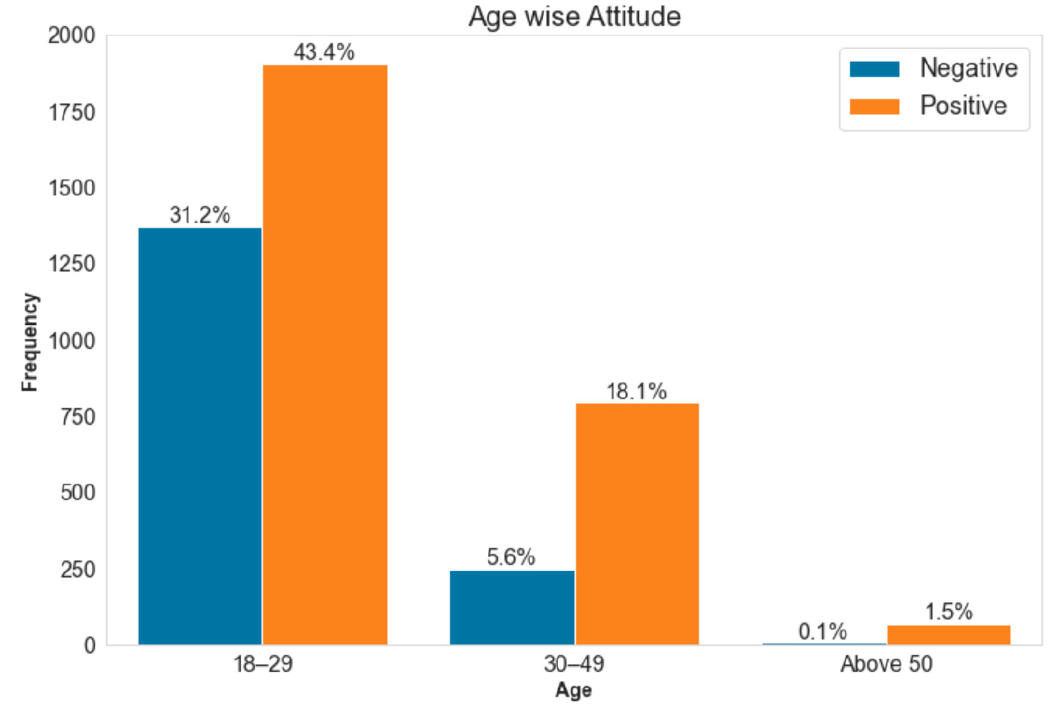
Figure 3. Association between attitude and age. Note: Here percentage is calculated based on a total number of observations, i.e., 43.4% of the total participant’s attitude is positive. In Table 3, the row-wise percentage is calculated. Table 3. Association between Attitude and demographic variables ( n = 4392).